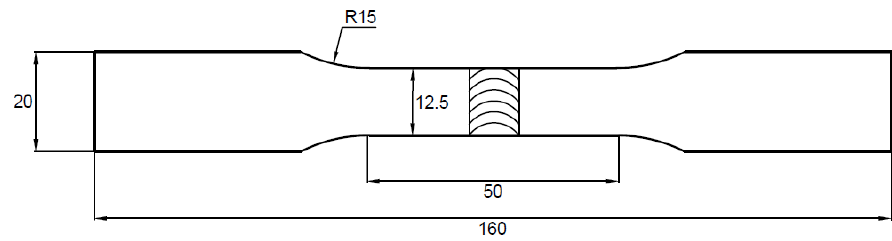
Figure 2. Geometry of the tensile